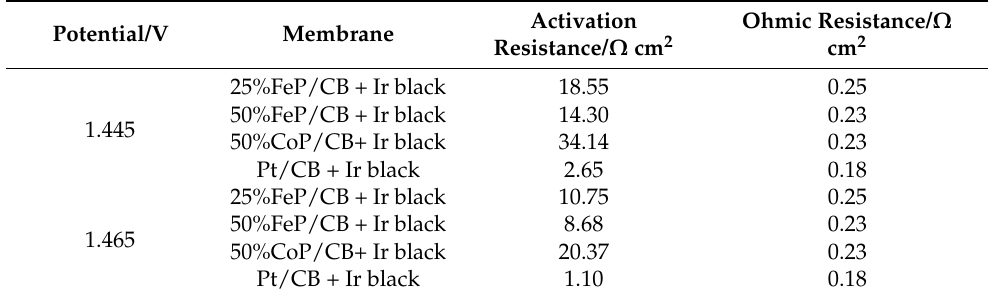
Table 5. Electrochemical impedance spectroscopy results for the best-developed catalysts and Pt. Potential/V